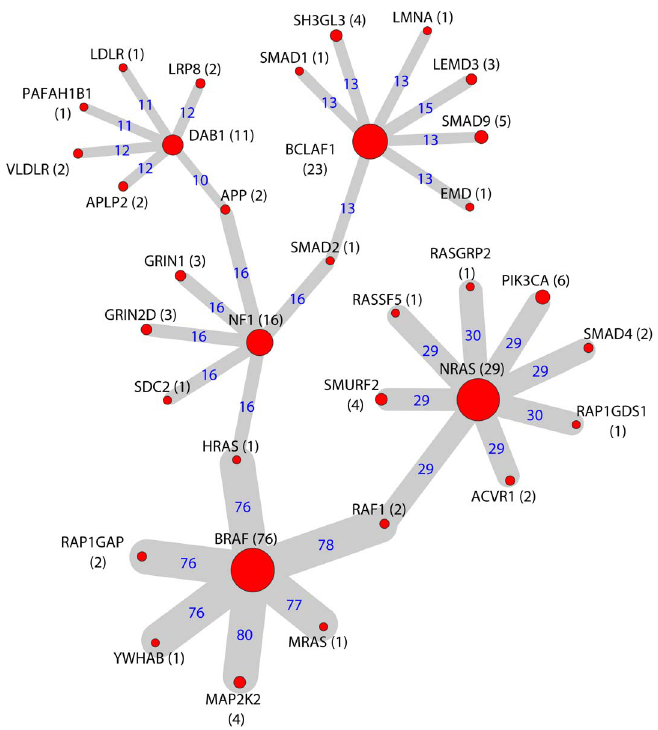
Figure 5. Selected subgraphs in the melanoma consensus mutation network. Node size is proportional to the number of samples harboring mutations in the corresponding gene (MutGene), as indicated in the parenthesis after the node name. Edge width is proportional to the number of samples harboring the interactions, which is also indicated by the number on each edge. For example, NRAS was mutated in 29 samples, PIK3CA was mutated in 6 samples, and the interaction between their protein products was found by RWR in 29 samples. In contrast, RASGRP2 was mutated in one sample and the interaction between its protein product and NRAS was found by RWR in 30 samples.